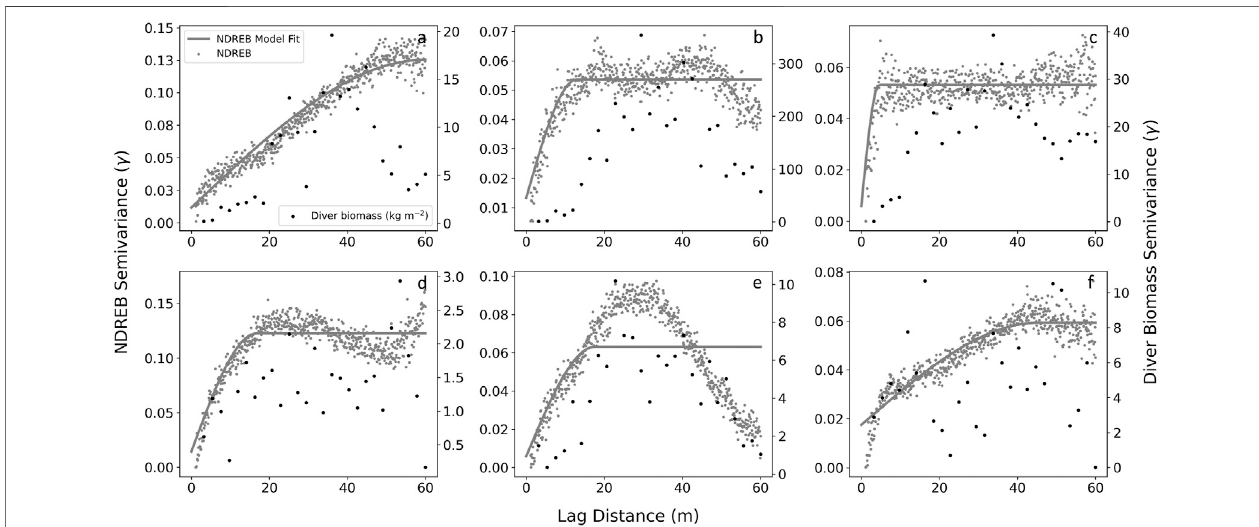
FIGURE 9 | Semi-variogram for each station NDREB (grey) and diver measured canopy biomass (black). NDREB are overlayed with a spherical model fi t. (A) Noyo Harbor; (B) Portuguese Beach; (C) Point Piños; (D) Otter Cove; (E) San Carlos Beach; (F) Hopkins Marine Station.